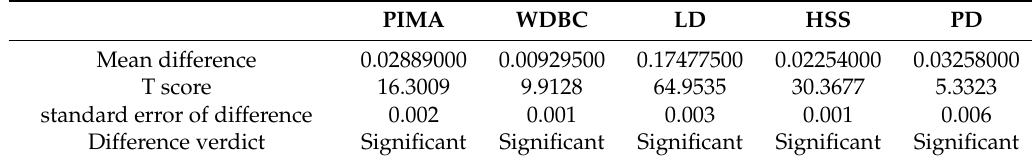
Table 7. Statistical test and of 5 University of California in Irvine (UCI) datasets: Pima Indian Diabetes PID, Wisconsin Breast Cancer WDBC, Liver Disorder LD, Haberman Surgery Survival HSS, and Parkinson’s PD, between ANN and ANN + PSO.